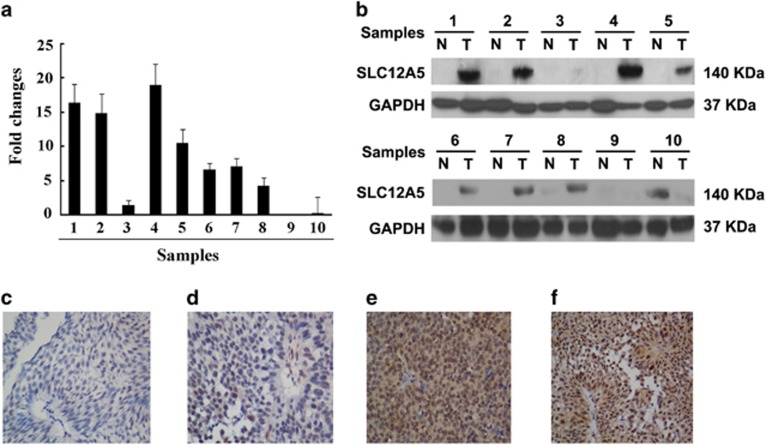
Expression of SLC12A5 mRNA and protein in human primary BUC surgical specimens as evaluated by qRT-PCR, western blot and IHC. (a) The mRNA expression of SLC12A5 is upregulated in 10 BUC tissues than in matched adjacent noncancerous tissues, analyzed by qRT-PCR analysis. (b) Representative results of expression of SLC12A5 protein in 10 paired BUC tissues and matched adjacent noncancerous tissues (T, BUC tissues; N, matched noncancerous tissues). (c–f) IHC analysis of SLC12A5 protein expression in primary BUC surgical specimens (× 400). (c) Low expression of SLC12A5 was observed in a BUC tissue (case 18), in which <20% of tumor cells demonstrated staining of SLC12A5. (d) Another BUC (case 89) tissue showed low expression of SLC12A5, in which 20–50% of tumor cells demonstrated staining of SLC12A5. (e) High expression of SLC12A5 was observed in a BUC case (case 8). (f) Strong SLC12A5 IHC signaling was detected in the BUC cells (case 26)